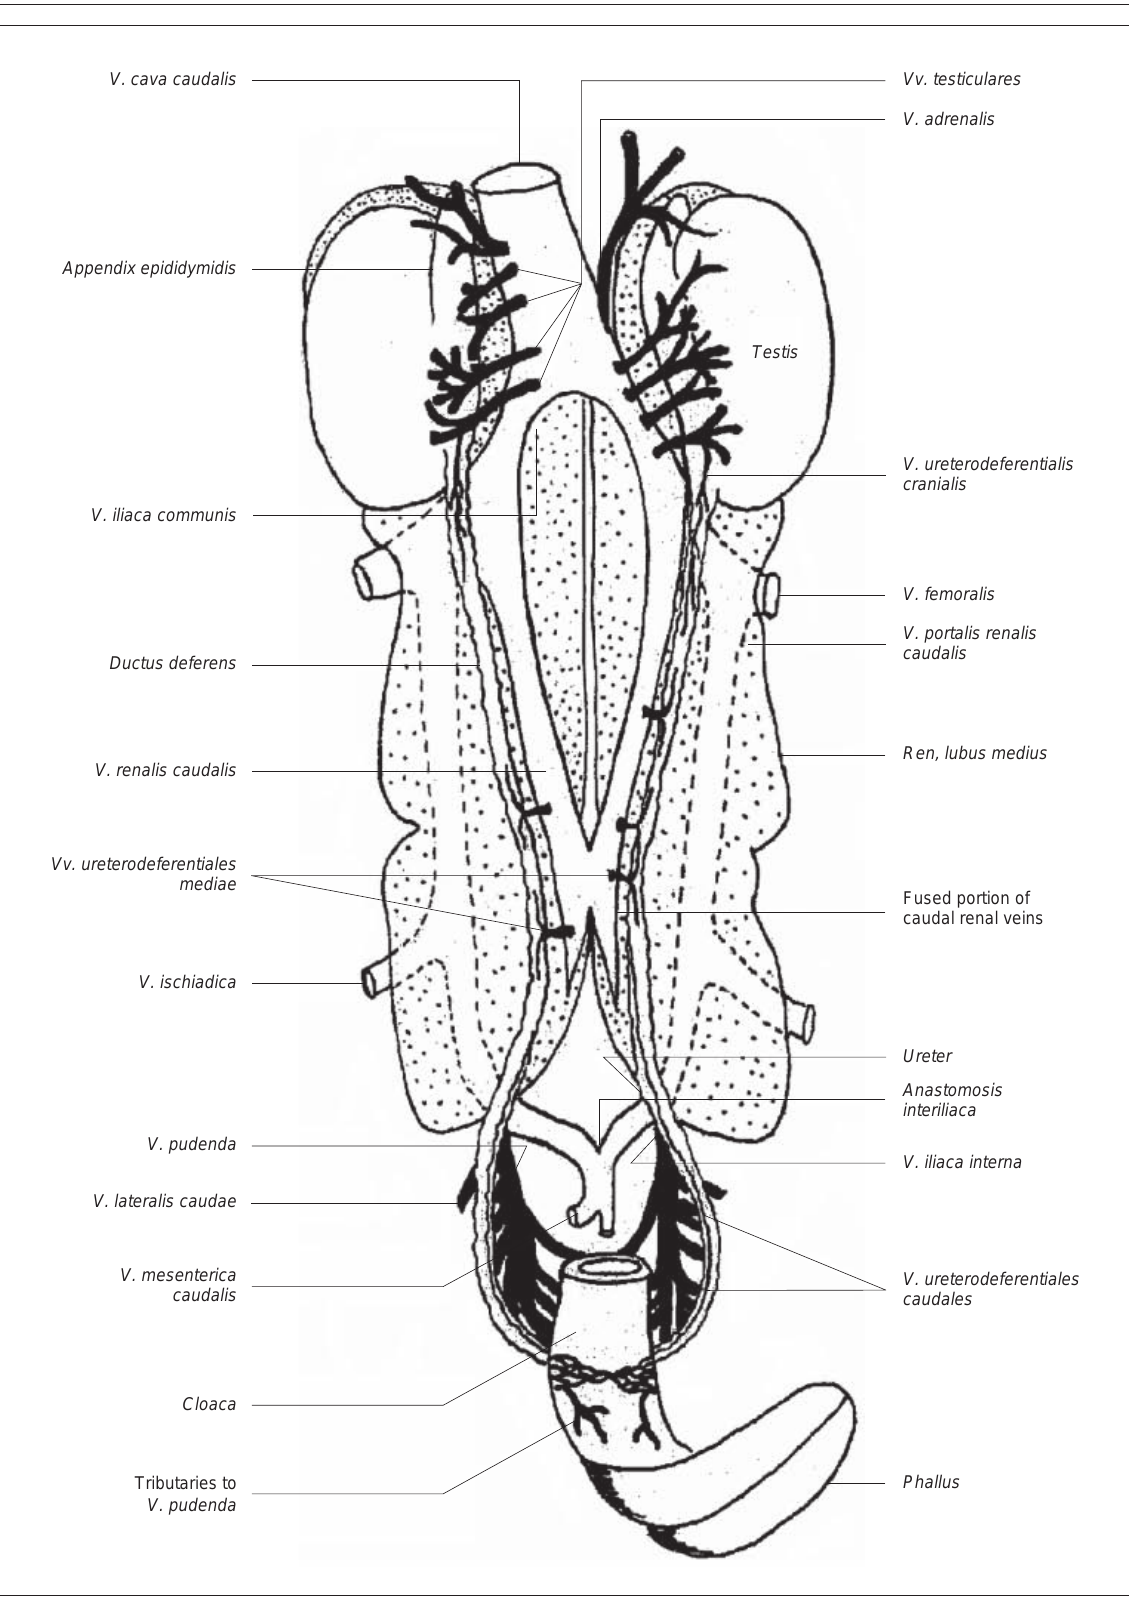
FIG. 1 A diagramatic sketch showing, in ventral view, the main veins draining the reproductive tract of the male ostrich. The testes are shown reflected laterally to illustrate the testicular veins and associated